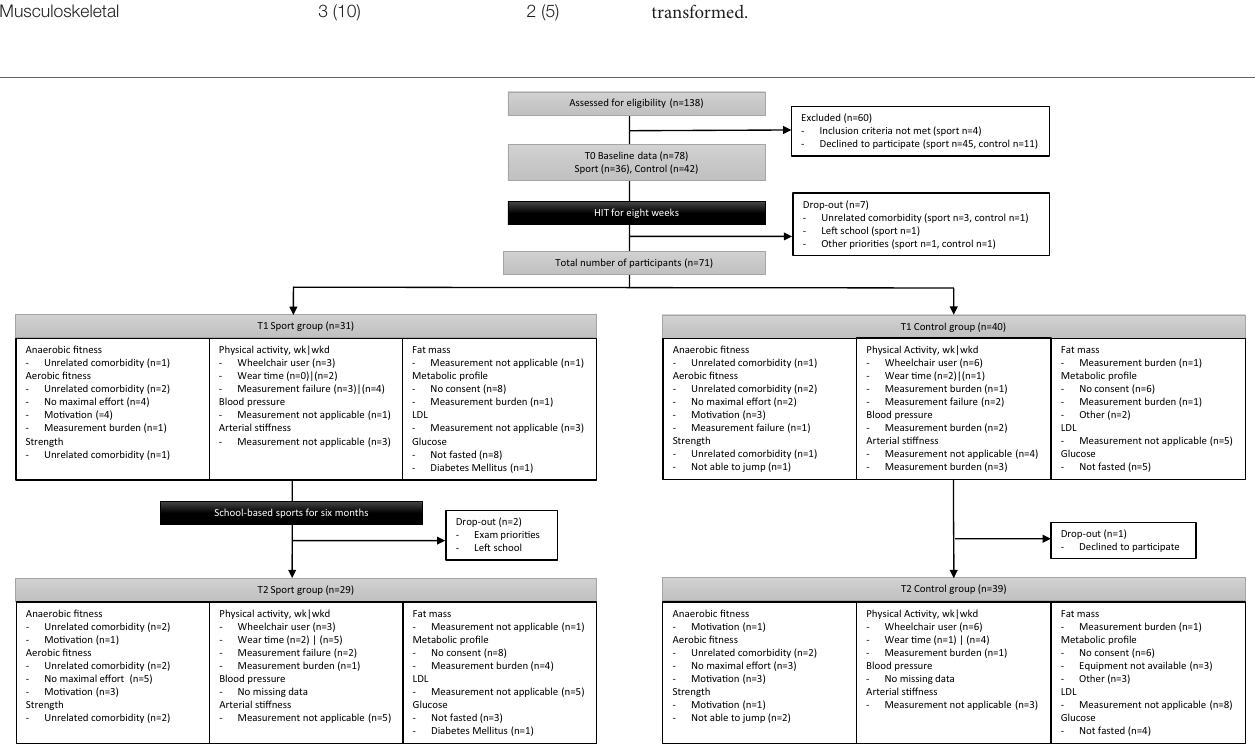
FigUrE 1 | A flowchart from initial inclusion to intervention and reasons for missing data per outcome